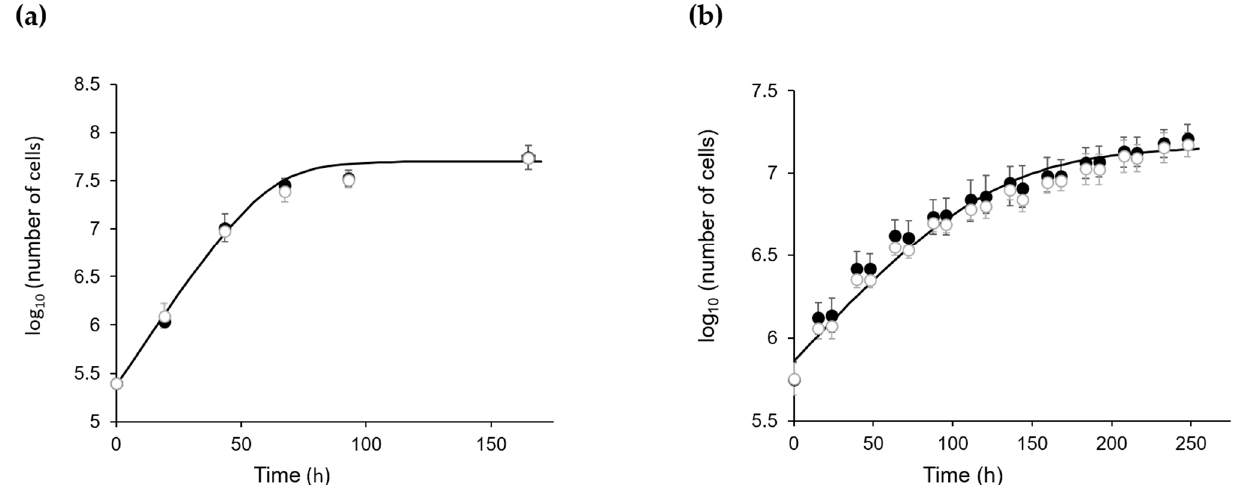
Figure 1. Growth of ∆ CP12-Cr (white circle) and WT-Cr (black circle). ( a ) photo-autotrophic and continuous moderate light conditions, 120 µ mol of photons · m 2 · s − 1 , 23 ◦ C, 110 rpm and 2% CO 2 . ( b ) photo-autotrophic and dark/light conditions: 50 µ mol of photons · m 2 · s − 1 , 8.5 h dark / 15.5 h light, 23 ◦ C, 110 rpm and 2% CO 2 . Growth curves were fitted to data point with Equation (1) (Materials and Methods) [24].